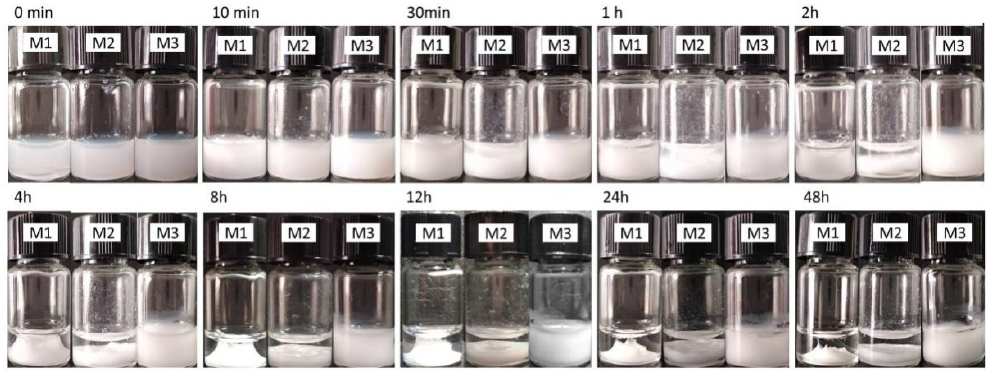
Figure 3. Photographs of the P(OEGMA-co-MEO 2 MA) hydrogels formed from M1 – M3 microgels at different times.